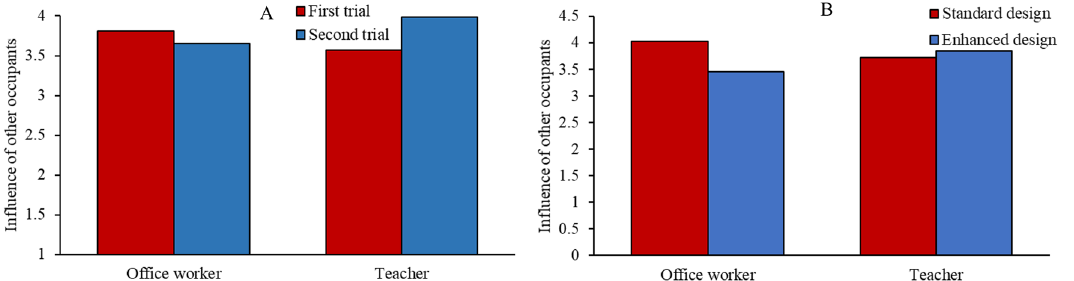
Figure 7. Influence of other occupants on participants’ responses. ( A ): the effect of building × order × occupation interaction. ( B ): the effect of design × occupation